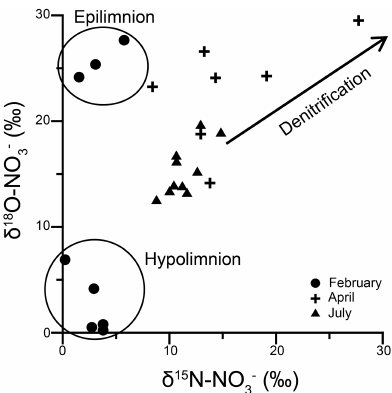
Figure 4. Nitrogen and oxygen isotopic composition of dissolved nitrate during three different periods in 2014. February represents the early or weak stratification period with two distinct clusters of epilimnetic (0–10m) and hypolimnetic (15–48m) samples. April is a period of intense water-column stratification and a denitrification signal is observed in the bottom waters. July is a period of monsoon holomixis when the water column has uniformly high nitrate